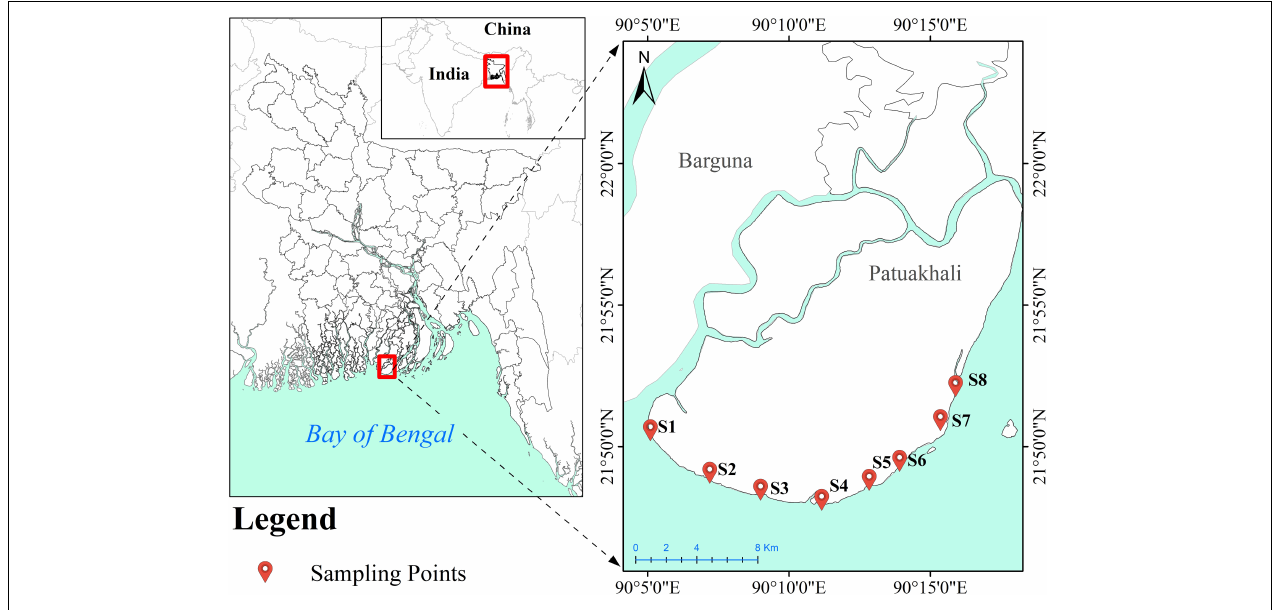
FIGURE 1 | Sampling points in Kuakata Beach along with the Bay of Bengal Coast,